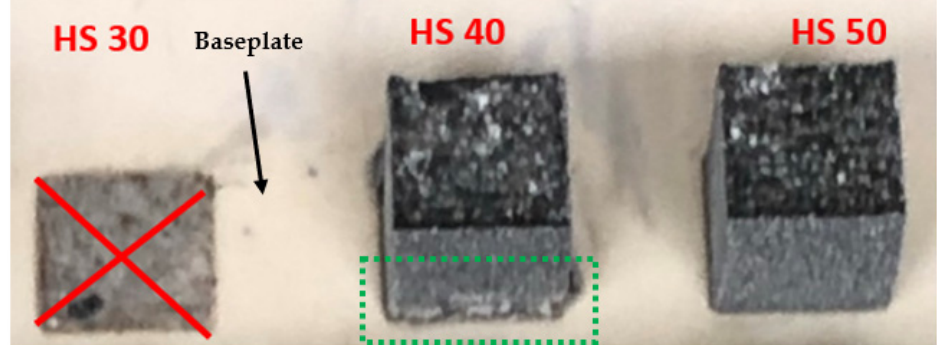
Figure 12. Alumina samples (10 × 10 × 10 mm 3 ) printed with different hatching distances, laser power 95 W, and scanning speed 200 mm/s.